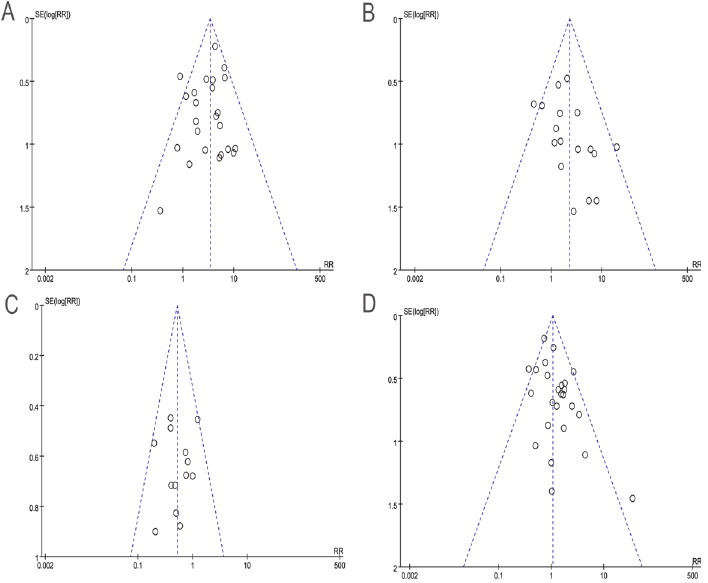
Fig 3. Funnel plot of the outcome of clinicopathological characteristics and the EML4-ALK fusion gene. (smokers vs non-smokers; B adenocarcinomas vs non-adenocarcinomas; C stages I-II vs stages III- IV; D male vs